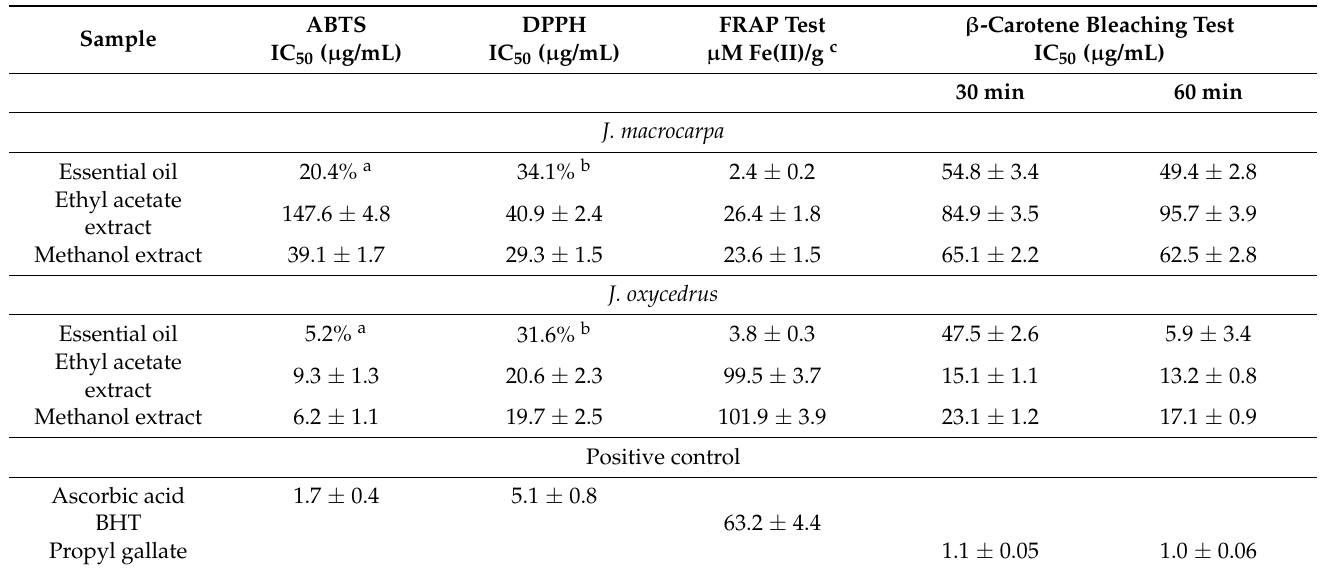
Table 3. Antioxidant activity of essential oils and extracts of J. macrocarpa and J. oxycedrus